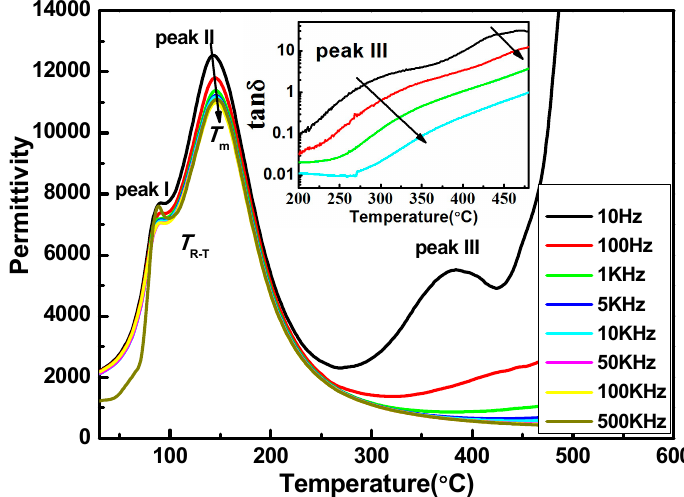
Figure 4. Temperature dependence of permittivity for Fe-substituted PMN-32PT ferroelectric crystal at different frequencies.